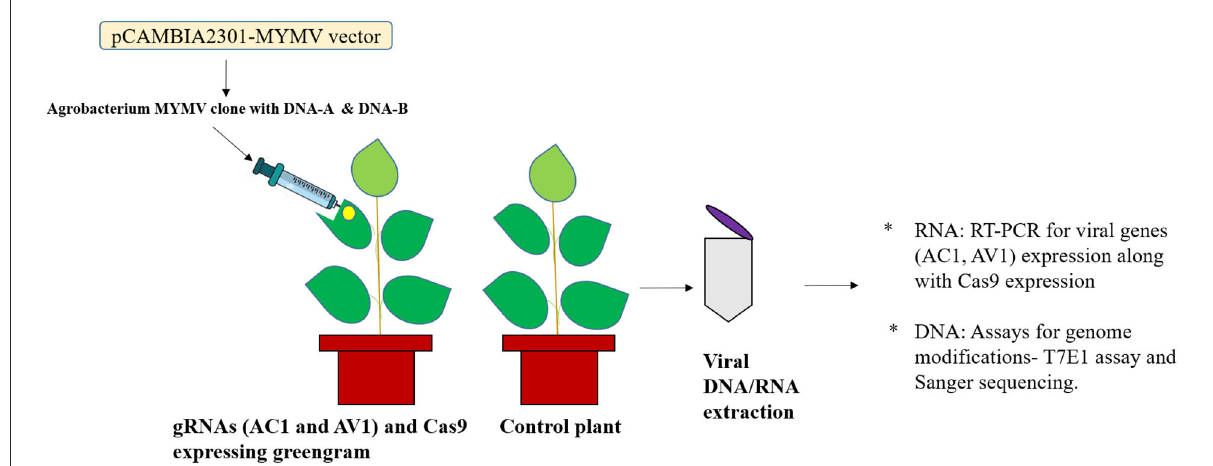
FIGURE5 Schematic representation of Agroinfiltration. (A) Agrobacterium containing engineered MYMV genome was infiltrated at abaxial leaf side of control and transgenic greengram plants expressing gRNAs (AC1 and AV1) and Cas9, (B) Samples collected for molecular analysis such as RNA: for analyzing transcripts of RNA and DNA: for detection of viral genome editing using T7EI assay and Sanger sequencing.